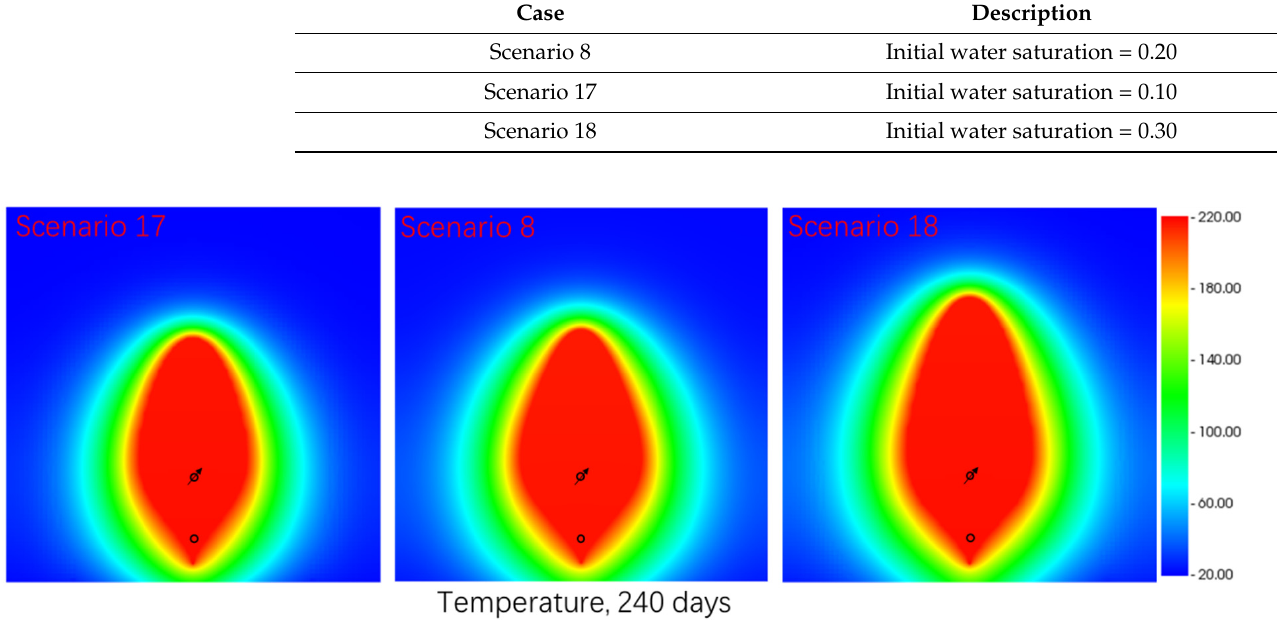
Figure 16. Cross-sectional temperature distributions of scenarios 8, 17 and 18 under varying initial water saturation.